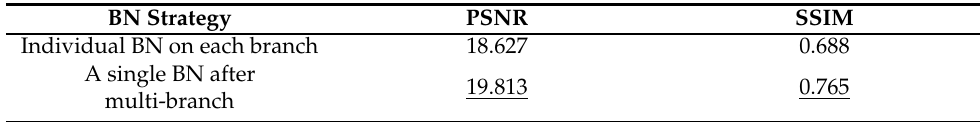
Table 3. Ablation study on different BN strategies. Best results are